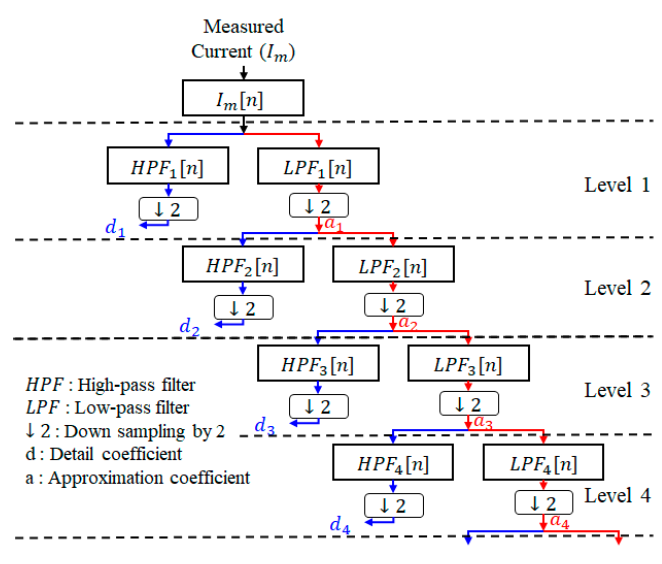
Figure 2. Wavelet decomposition tree.